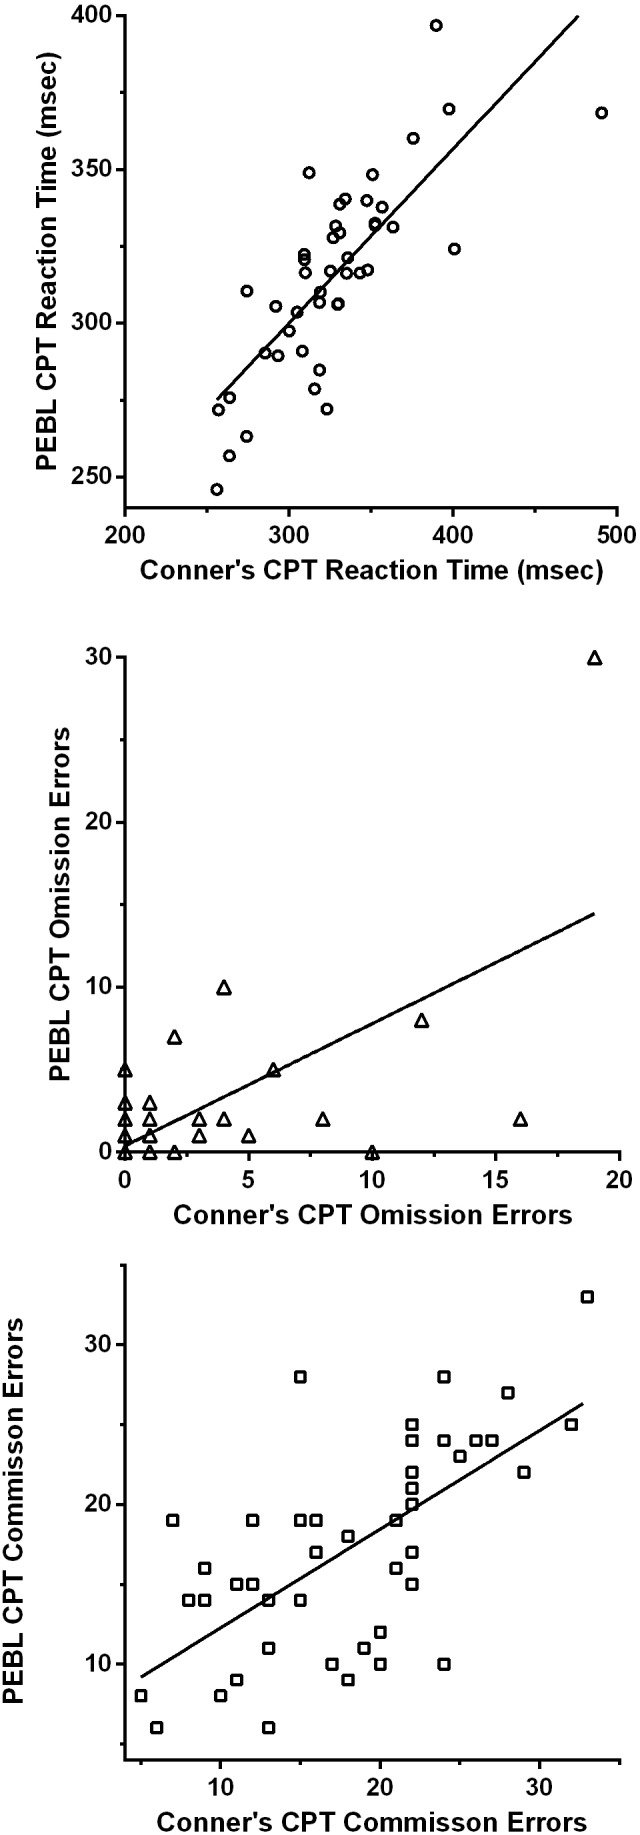
Scatterplots depicting the association between measures on the Psychology Experiment Building Language and the Conner’s Continuous Performance Test including reaction time (top: r(42) = + .78, 95% CI [.63–.87], p < .0005), omission errors (middle: rP(42) = + .65, 95% CI [.44–.79], p < .0005) and commission errors (bottom: r(42) = + .66, 95% CI [.45–.80], p < .0005).